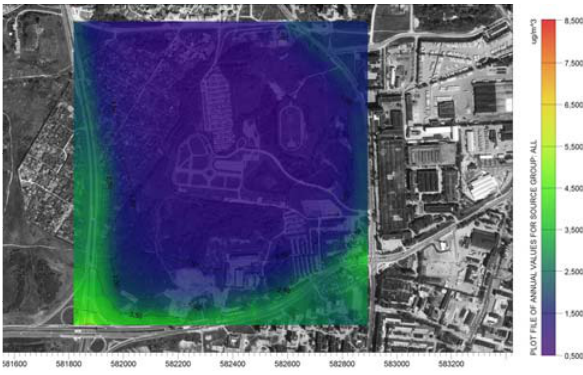
Fig 7 . Graphic view of pollutant dispersion modeling (PM) According to the Lithuanian requirements, the big-